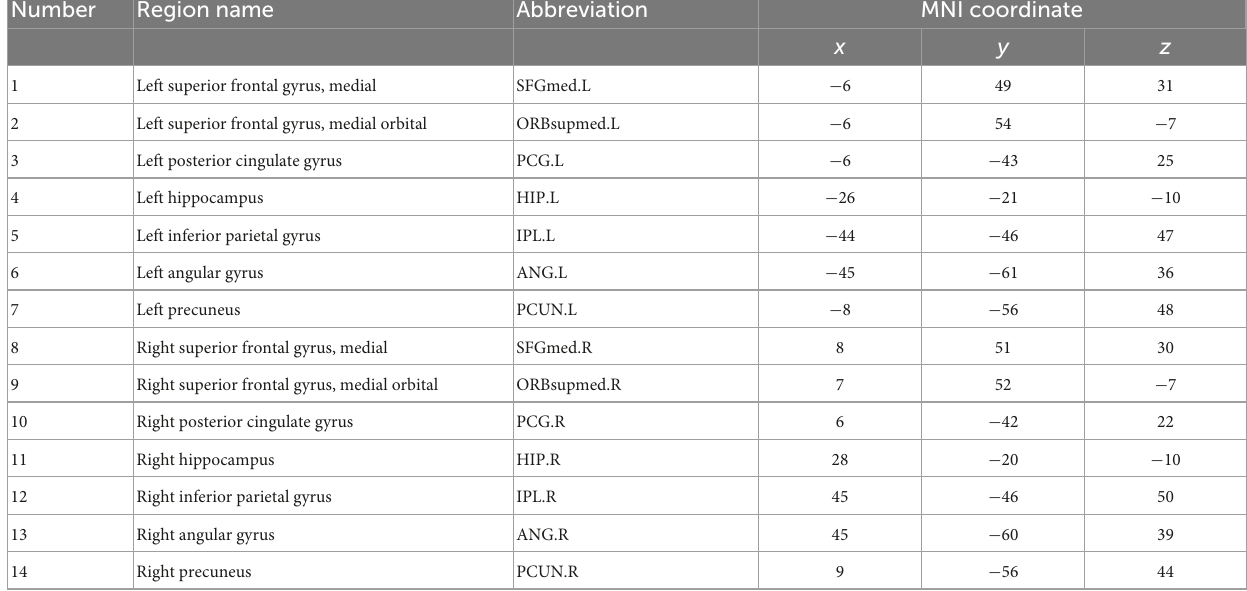
TABLE 1 List of volumes of interest in